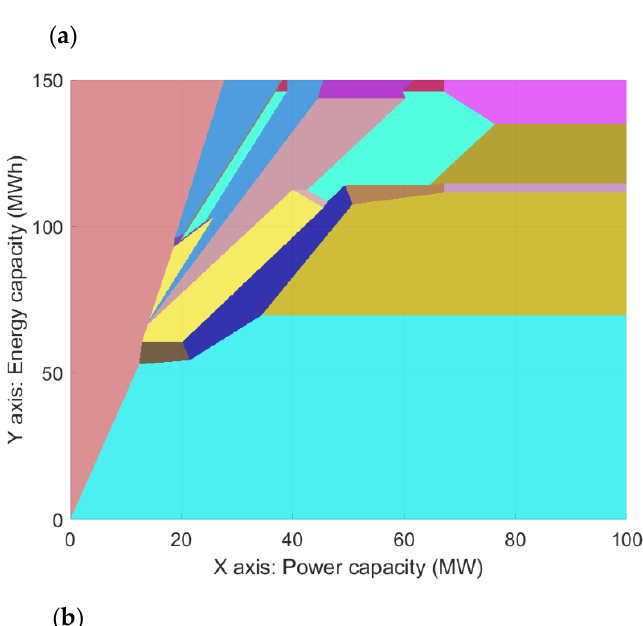
Figure 6. Results of distributionally robust multi-parametric mixed integer linear program (mp-MILP) ( a ) optimal value function and ( b ) critical regions.